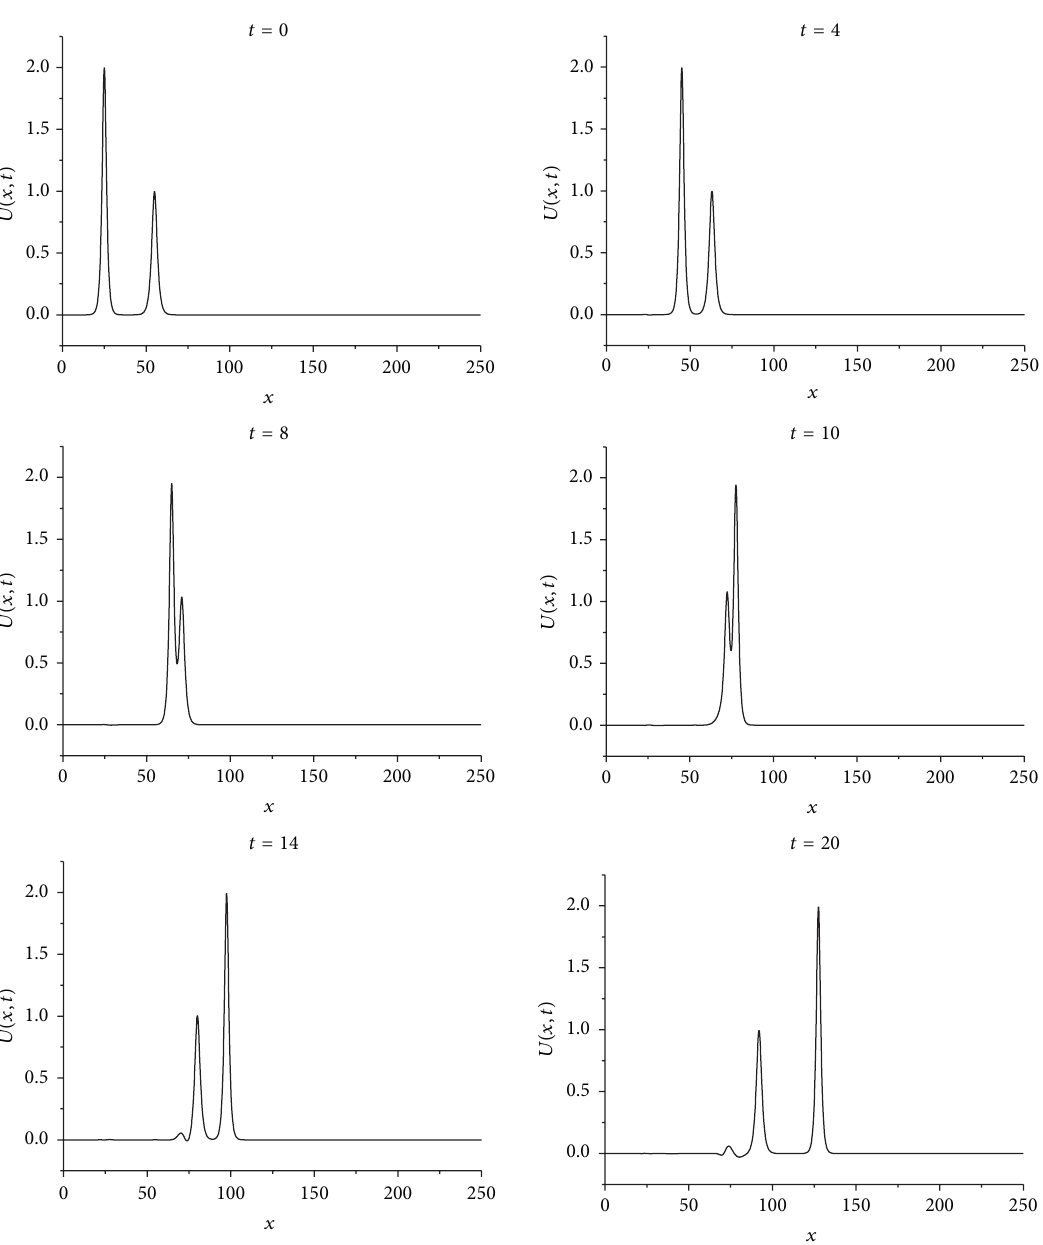
Figure 4: Interaction of two solitary waves with 𝑡 = 0, 4, 8,10, 14 , and 20